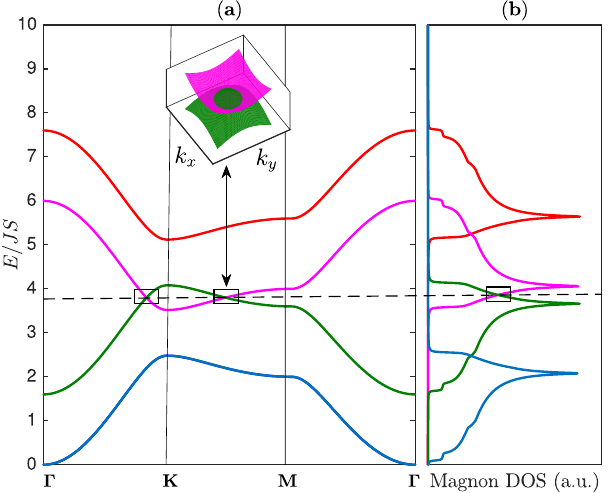
Figure 5. The magnon energy bands and magnon density of states. ( a ) Magnon band structures with Dirac magnon-nodal lines (rectangular boxes), but gap Dirac magnon points along the Brillouin zone paths in Fig. 1(b). The dashed line corresponds to the energy of Dirac magnon-nodal lines at E = E 0 . The inset shows the 3D band near K as indicated by the same colour codes of the 2D bands. ( b ) The corresponding magnon density of states (DOS). The plots are generated by setting Δ DM = 0.1 J , J L = 0.8 J